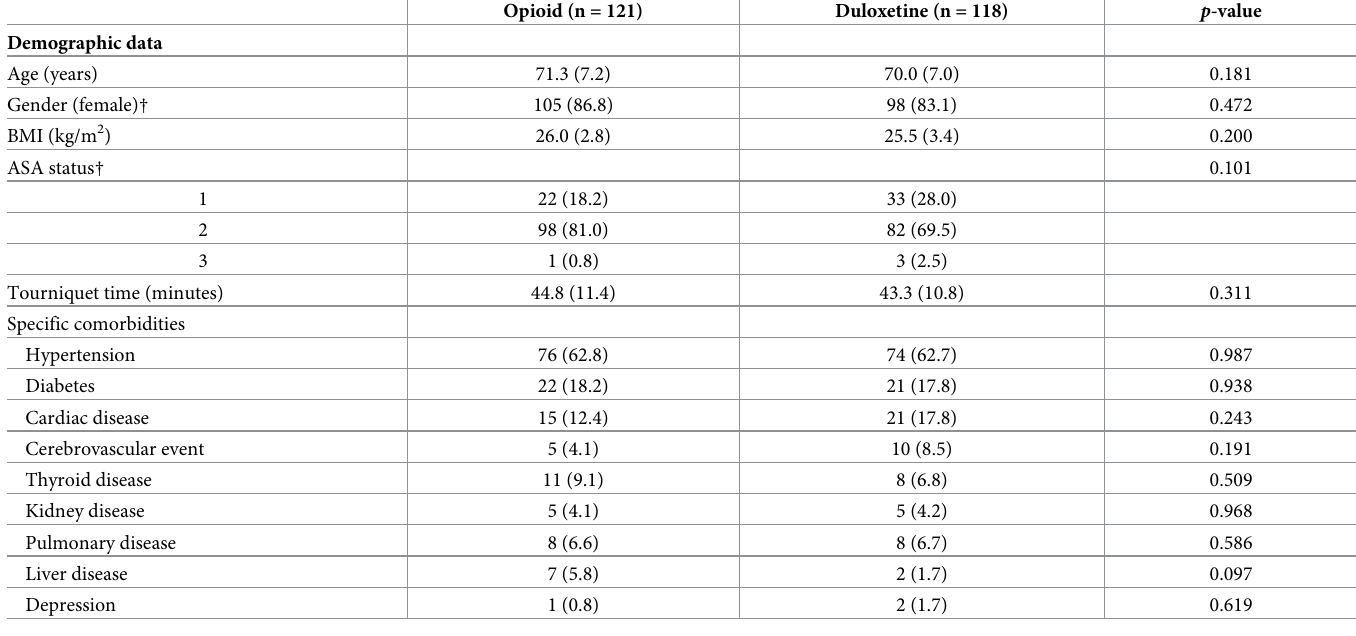
Table 1. Patient demographics and preoperative characteristics �